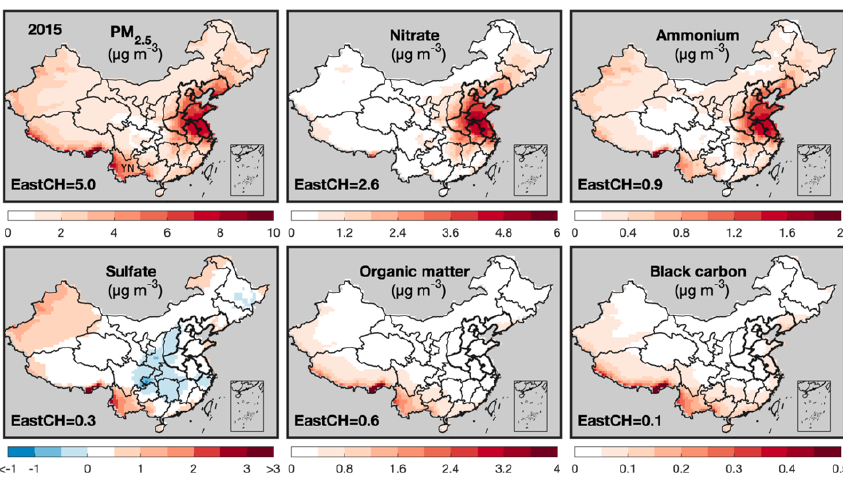
Figure 3. Simulated annual-mean contributions of foreign anthropogenic emissions to China’s total and compositional PM 2 . 5 concentrations in 2015. Thick black lines outline eastern China, as discussed in this work. Text in the bottom left corner of each panel refers to mean concentrations (µgm − 3 ) over eastern China contributed by foreign anthropogenic emissions. The foreign impact on China’s anthropogenic dust concentrations is shown in Fig. S3. YN in the PM 2 . 5 subplot refers to the location of Yunnan